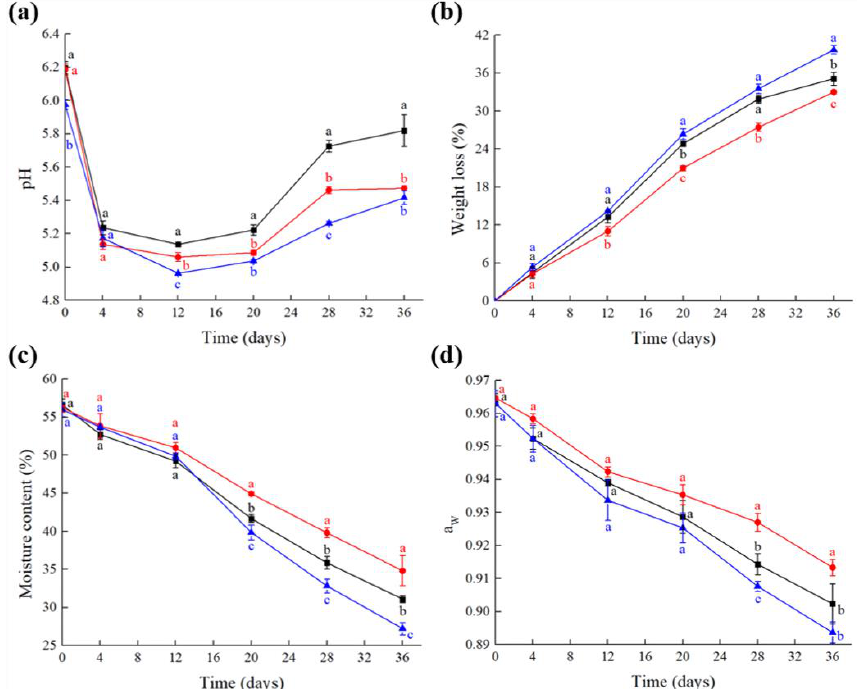
Figure 1. The pH ( a ), weight loss ( b ), moisture content ( c ) and a w ( d ) in the fermented sausages. ( ■ ) N: fermented sausages with 3% NaCl (reference), ( ● ) L: fermented sausages with 2.25% NaCl (25% reduction), ( (cid:78) ) R: fermented sausages with partial replacement of 25% NaCl. The different lowercase letters indicate significant difference ( p < 0.05) between the samples by Tukey’s